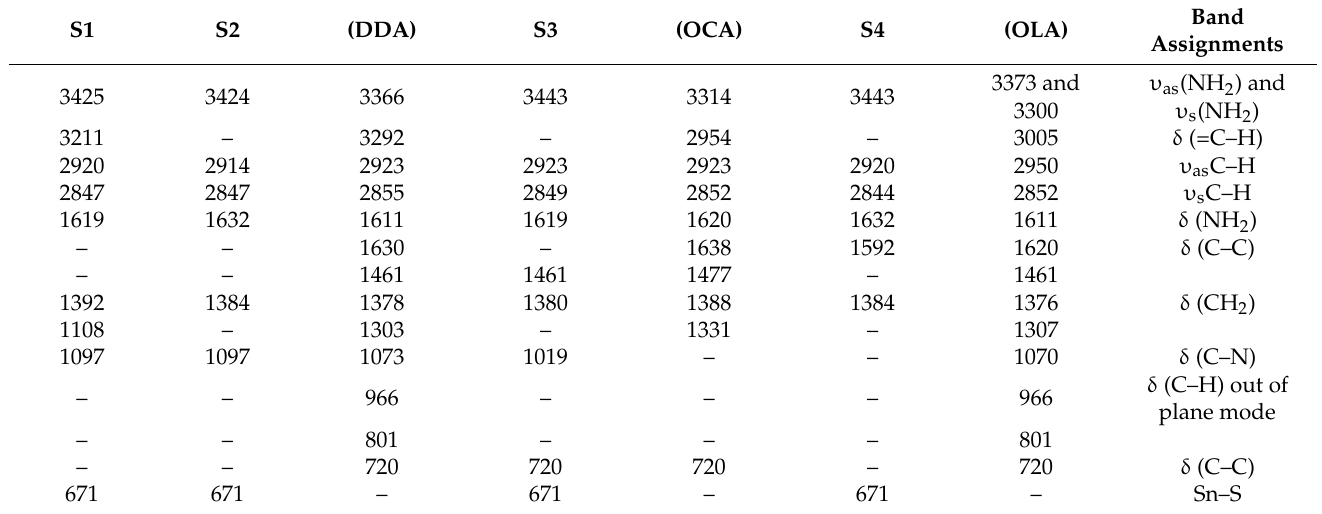
Table 2. Assignments of IR peaks for the SnS 2 samples and the alkylamines used as capping agents.